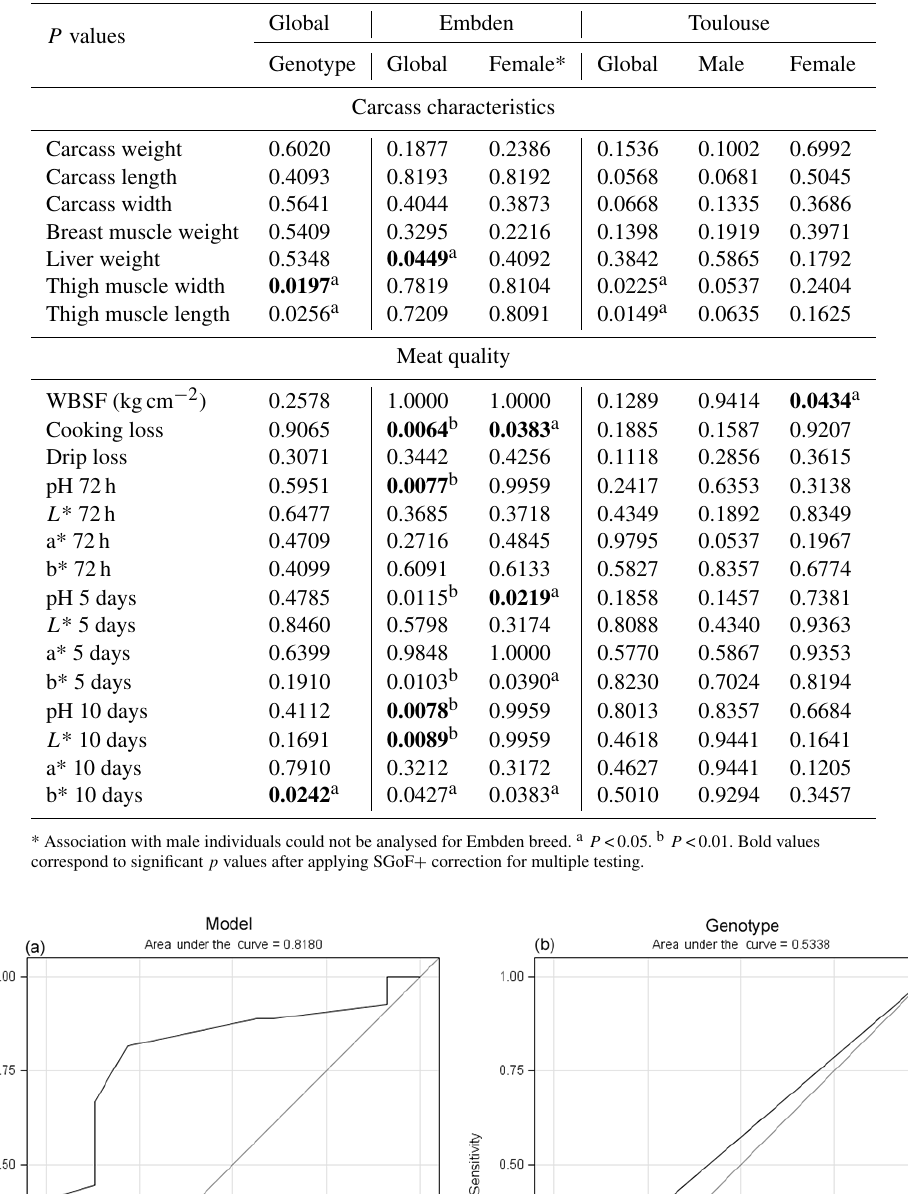
Table 2. Association analysis between g.68G → A (CAPN1 gene) with carcass characteristics and meat quality traits using a logistic regres- sion procedure and general linear model in Toulouse and Embden subpopulations.